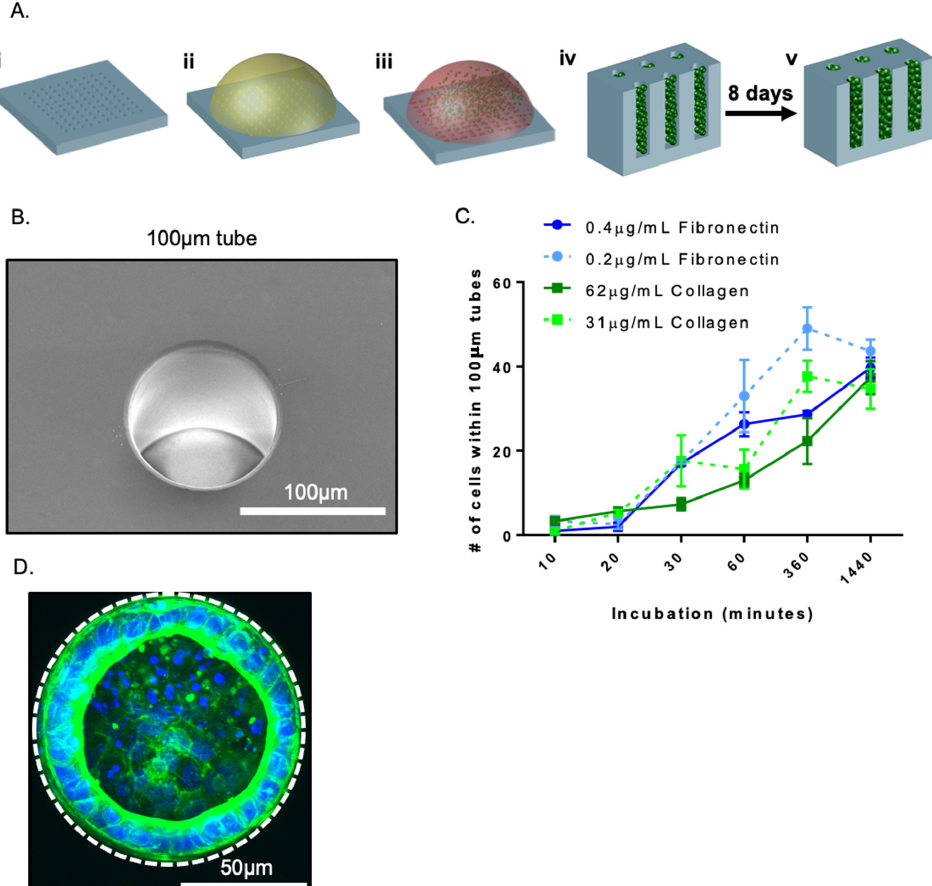
Figure 1. Schematic of tubular self-assembly. ( A ) PDMS substrates containing tubes of the desired dimensions were generated by moulding against a topographically patterned master produced using photolithography ( i ). Substrates were coated with an extracellular matrix overnight ( ii ) and subsequently were coated in day 17 progenitor cells at a selected density ( iii ) which were allowed to adhere for 25 min before non-adherent cells were washed off the substrate surface ( iv ); cells seeded into cavities self-organized into monolayers ( v ) within the architecture over a period of 3 to 8 days. ( B ) Representative scanning electron microscopy of 100 µ m tubes; bar, 100 µ m. ( C ) Quantification of the number of cells within 100 µ m tubes as a function of incubation time; n = 3. ( D ) Representative fluorescent micrograph of day 17 lung progenitor cells, F-actin (green) and nuclei (blue), after 2 days of culture seeded within 100 µ m tubes; bar, 50 µ m; the dotted white line approximates the PDMS